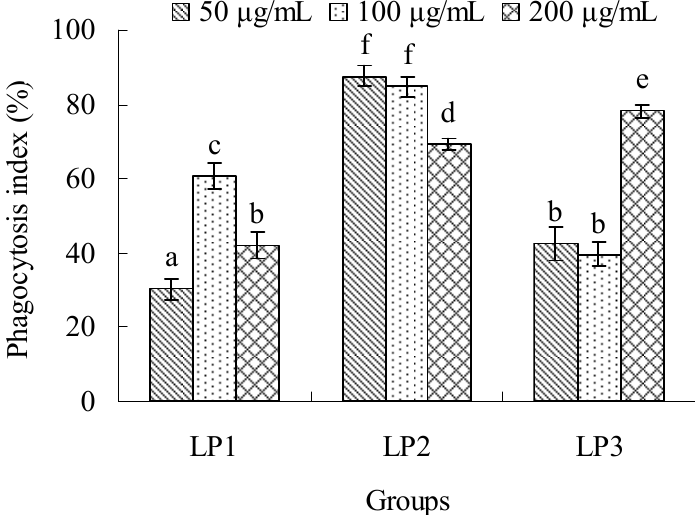
Figure 7. Effects of LP1-3 on the phagocytosis of macrophages. The activity was evaluated by the phagocytosis index of neutral red and expressed as means ± SD (n = 3). The statistically significant differences among the groups were evaluated with ANOVA followed by the S-N-K test. Different letters in the figure represent the statistical difference at P < 0.05.